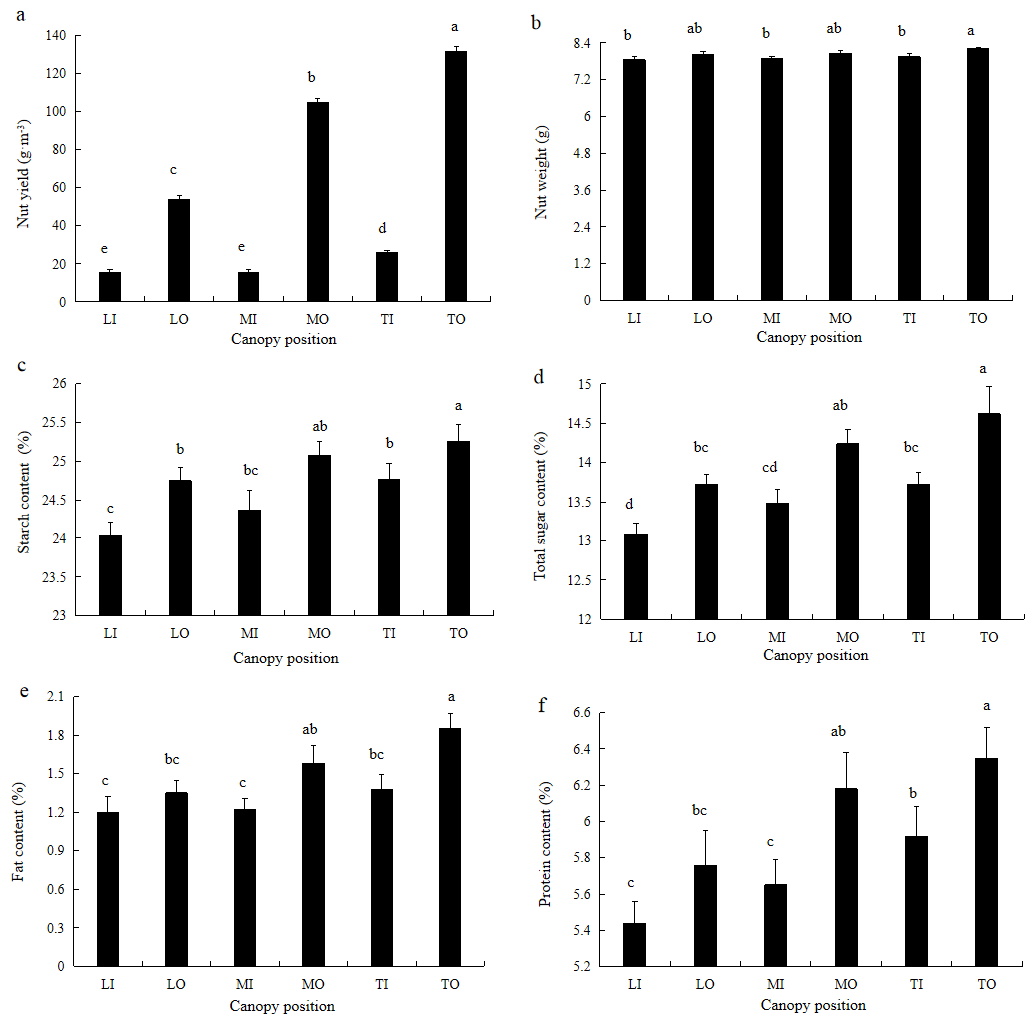
Figure 2. Nut yield and quality at different positions within the canopy. LI: inner canopy of the lower layer; LO: outer canopy of the lower layer; MI: inner canopy of the middle layer; MO: outer canopy of the middle layer; TI: inner canopy of the top layer; TO: outer canopy of the top layer. ( a ) Nut yield; ( b ) nut weight; ( c ) starch content; ( d ) total sugar content; ( e ) fat content; ( f ) protein content. Significant differences are highlighted as a–e. Bars with different letters differ statistically according to LSD’s test, where α = 0.01.